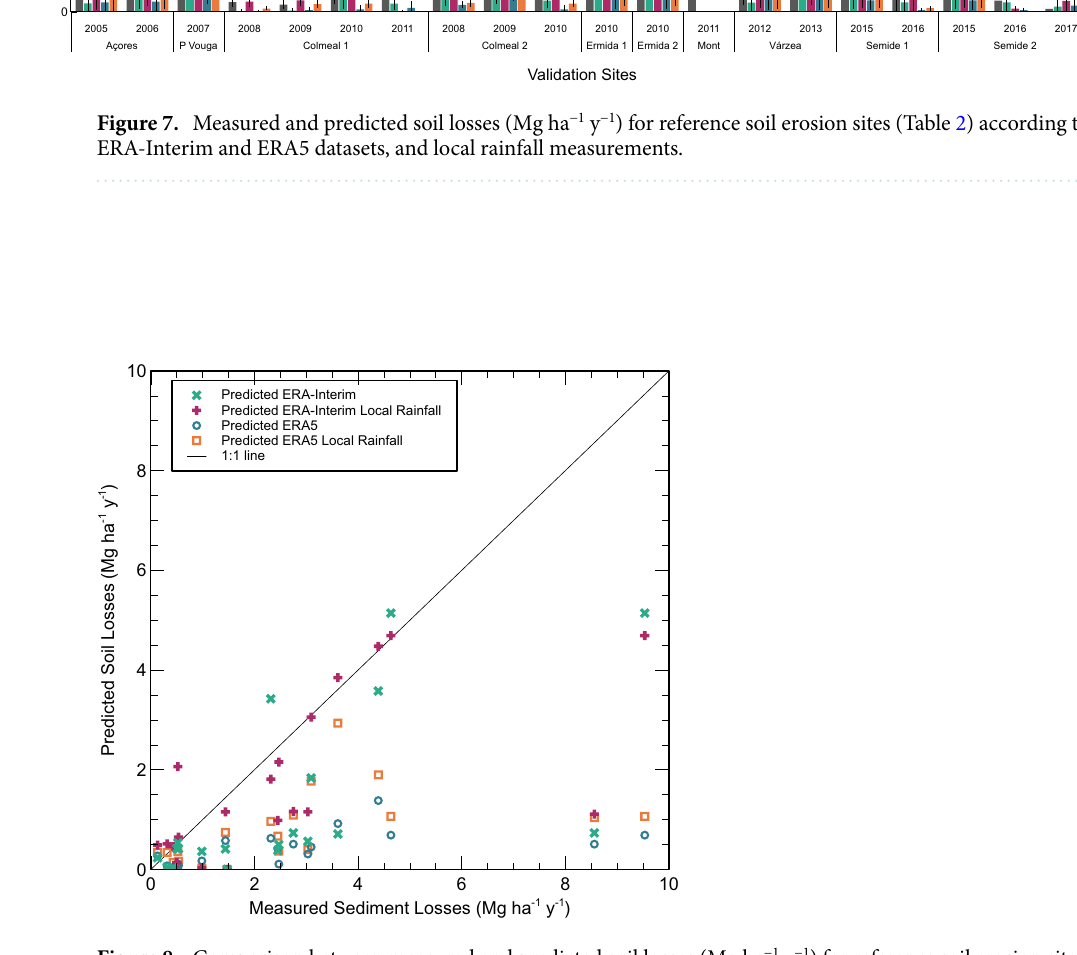
Figure 8. Comparison between measured and predicted soil losses (Mg ha −1 y −1 ) for reference soil erosion sites (Table 2) according to ERA-Interim and ERA5 datasets, and local rainfall